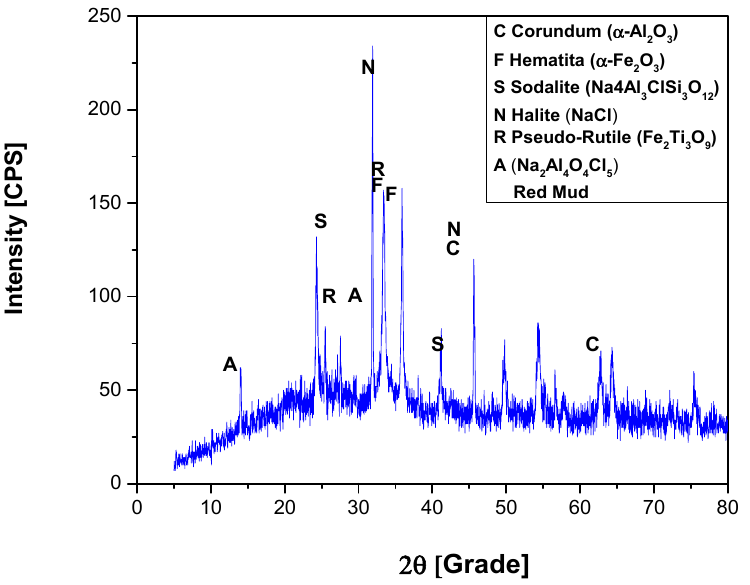
Figure 9. XRD of red mud pellets activated with 1.0 M HCl after calcination at 400 ◦ C. The XRD of red mud catalyst is shown in Figure 10. Two peaks are observed, one of high intensity observed on the position 2 θ : 24.5 (100%), and another of medium intensity on the position 2 θ : 14.0 (40%) associated to the crystalline Sodalite (Na 4 Al 3 ClSi 3 O 12 ). Two peaks associated to sodium oxide (Na 2 O) were observed, one of high intensity on the position 2 θ : 32.7 (100%) and one of low intensity on the position 2 θ : 47 (37.9%). The crystalline phase Nepheline (NaAlSiO 4 ) was observed in two peaks, one of high intensity on the position 2 θ : 20.8 (100%) and one of medium intensity on the position 2 θ : 34.3 (56.2%). Furthermore, a high intensity peaks was observed on the position 2 θ : 35.6 (100%) and a peak of low intensity on the position 2 θ : 62.9 (35.9 %), associated to Fe 2.18 O 4 Ti 0.42 . Finally, the peaks associated to the crystalline corundum phase ( α -Al 2 O 3 ) of high and low intensity were observed on the positions 2 θ : 25.7 (100%) and 2 θ : 43.3 (30.6%).